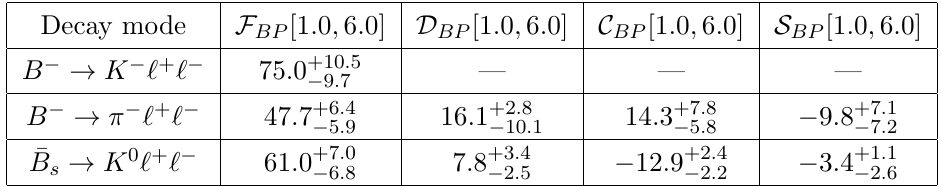
Table 4 . The parts of the B ! P‘ + ‘ (cid:0) amplitudes squared, as de(cid:12)ned in eqs. (2.11){(2.14), in the units [GeV 3 ], for the bin [1 : 0 GeV 2 ; 6 : 0 GeV 2 ].